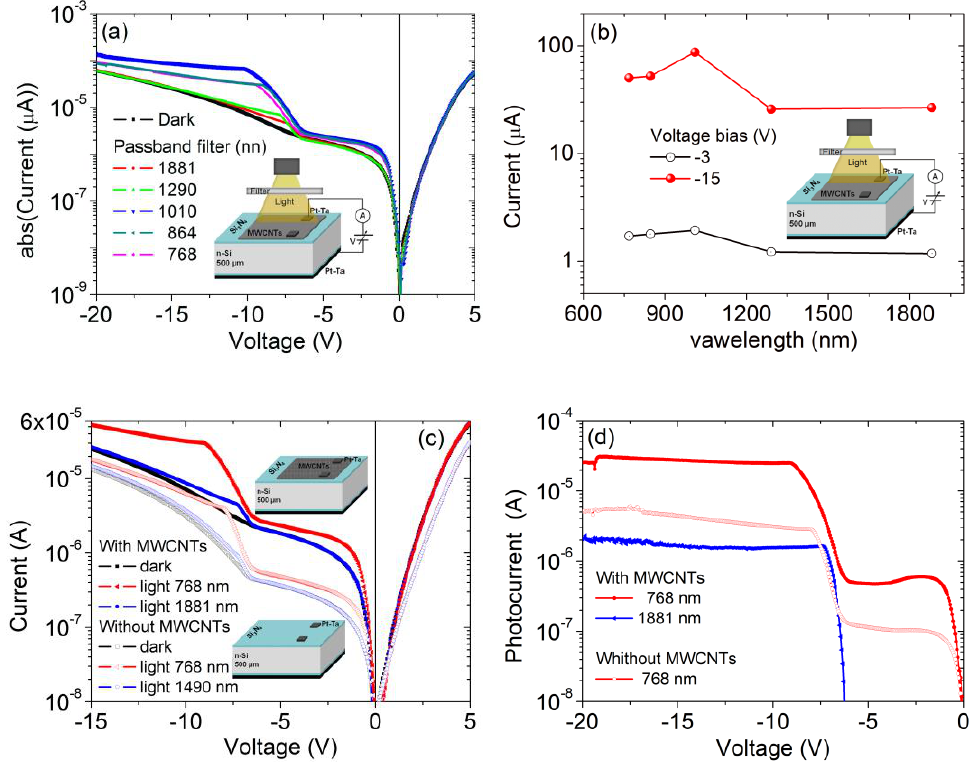
Figure 5. ( a ) I-V characteristics. ( b ) Photocurrent at V = − 3 V and V = − 15 V of the Pt-Ta_CNT / Si 3 N 4 / n-Si / Si 3 N 4 / Pt-Ta structure under the illumination of lights with di ff erent wavelengths. I-V characteristics ( c ) and photocurrent (current under illumination minus current in dark) ( d ) of the two vertical MISIM structures, with and without MWCNTs, for exposure to light of di ff erent wavelengths.